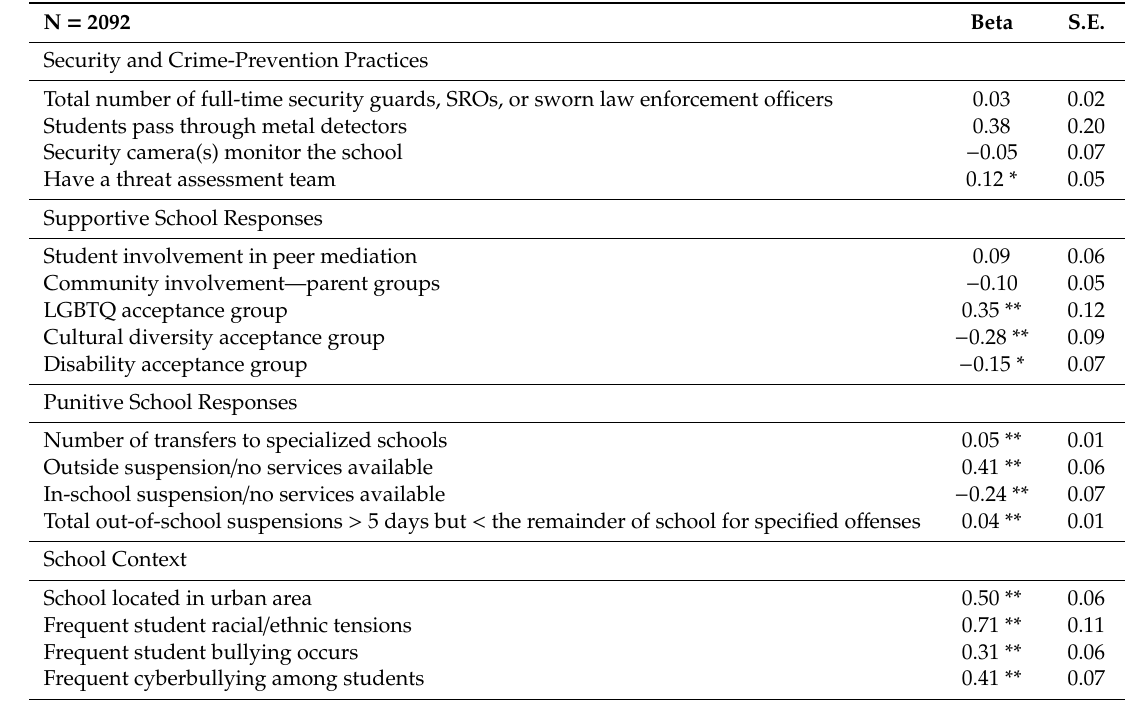
Table 2. Negative binomial regression results for number of violent incidents. N = 2092 Beta